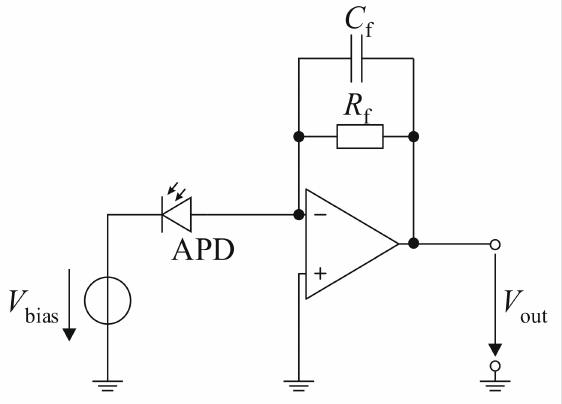
Figure 1. APD with biasing voltage and transimpedance